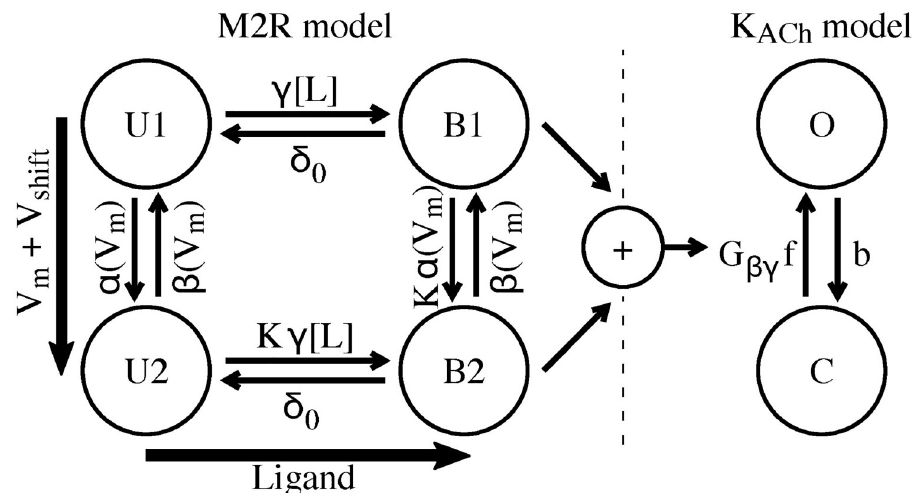
Fig 2. Markovian model describing the response of K ACh channels to different ACh concentrations and membrane voltages. The left sub-model describes the M2R, with states U1 and B1 for high ACh affinity and hyperpolarized voltages, and states U2 and B2 for low ACh affinity and depolarized voltages. The right sub-model represents the K ACh channel with the open state O and the closed state C. For further details, see the method